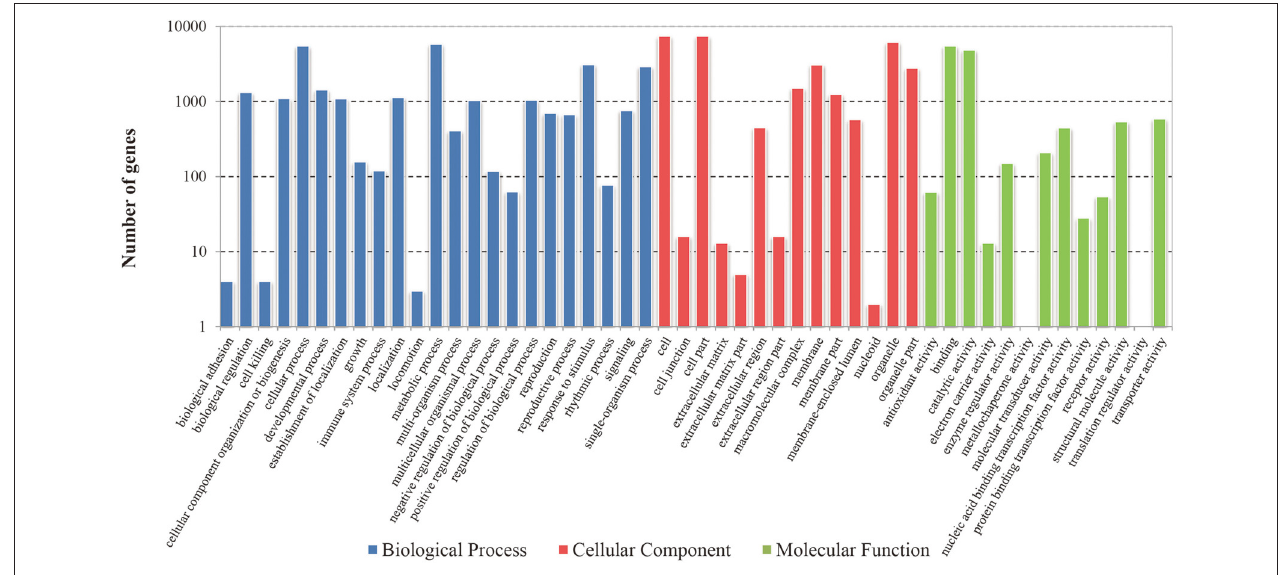
FIGURE 2 | The GO classification of identified DEGs in